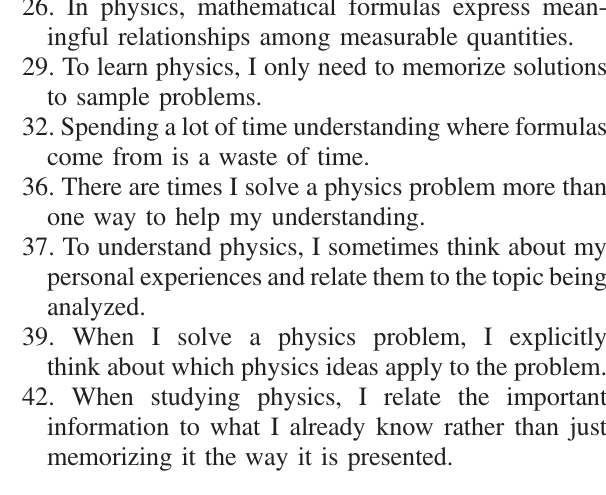
predictors. Analyses were conducted both with late-semester concept inventories as the dependent measure (Table IV) and with exam performance as the dependent measure (Table V). Tables VI and VII present parallel regression analyses with 2 CLASS factors (Learning Approach and Solving Approach) entered as predictors. Table VI shows analyses with TABLE IV. Regression-model summaries predicting late-semester concept inventory (FCI and BEMA) scores from prior knowledge measures and eight CLASS categories. Fall Active Physics (AP I); Fall Traditional Physics (TP I); Spring Active Physics (AP II); Spring Traditional Physics (TP II); number of observations ( N ); change in R